Question: Write a caption explaining this figure to a reader.
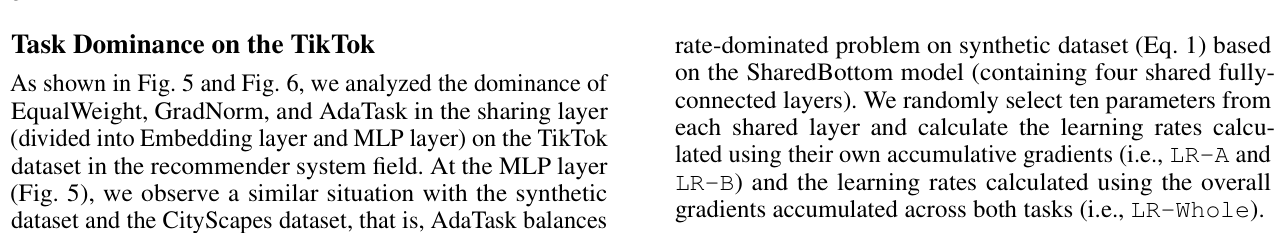
Answer: Illustration of learning rate dominance of randomly sampled parameters from the 1st to 4th layer for two MTL methods: (a) EqualWeight and (b) our AdaTask. The learning rate of Task A (i.e., LR-A) or Task B (i.e., LR-B) is based on Task A’s or Task B’s own accumulative gradient, respectively. The whole learning rate (i.e., LR-Whole) is based on the sum of accumulative gradients from both tasks.